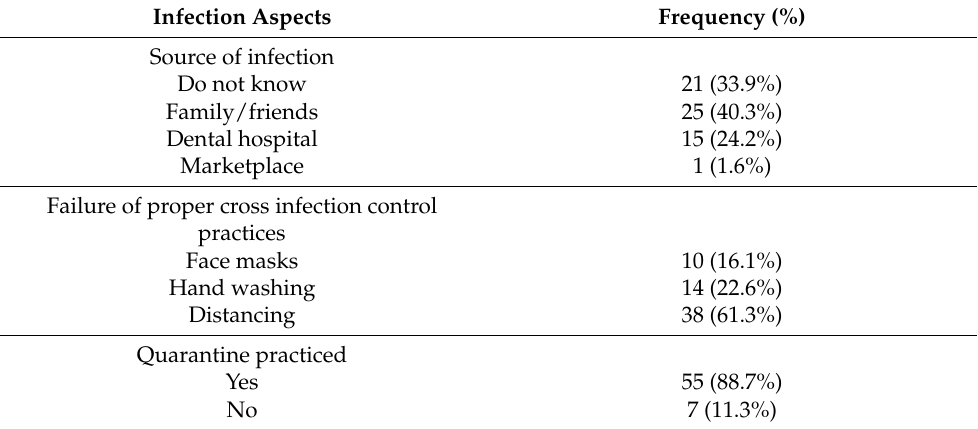
Table 2. Perceived sources of COVID-19 infection and improperly practiced cross-infection control practices as factors in infection transmission, as cited by the 62 individuals infected with COVID-19.